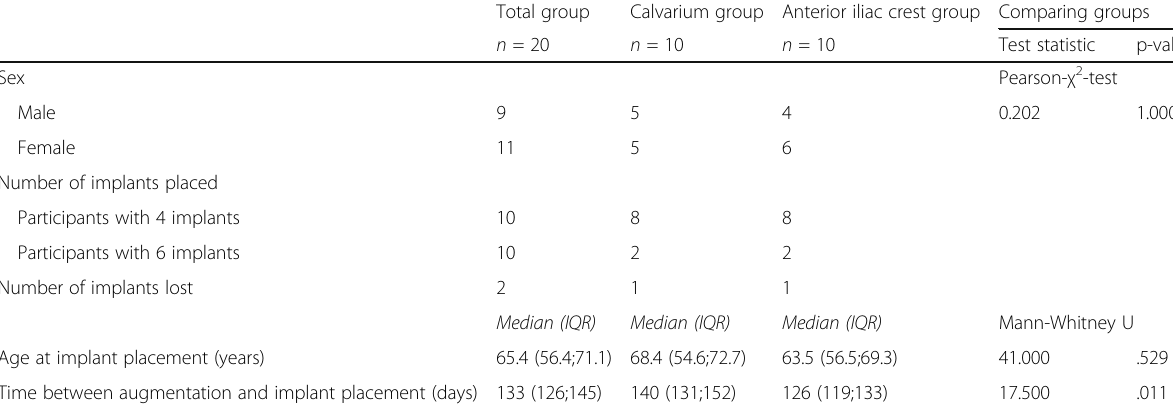
Table 1 Characteristics of the study group